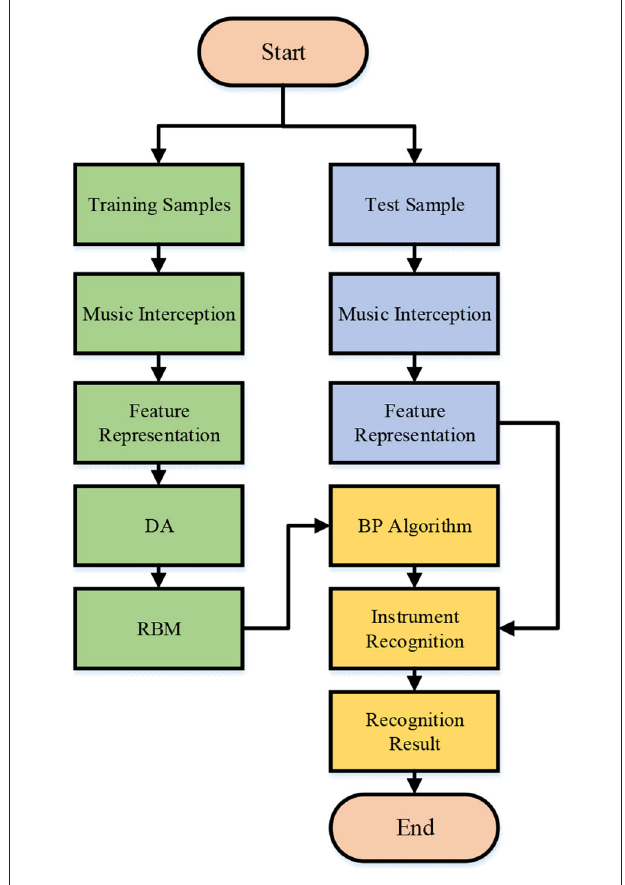
FIGURE 5 | Musical instrument recognition process based on HNN.